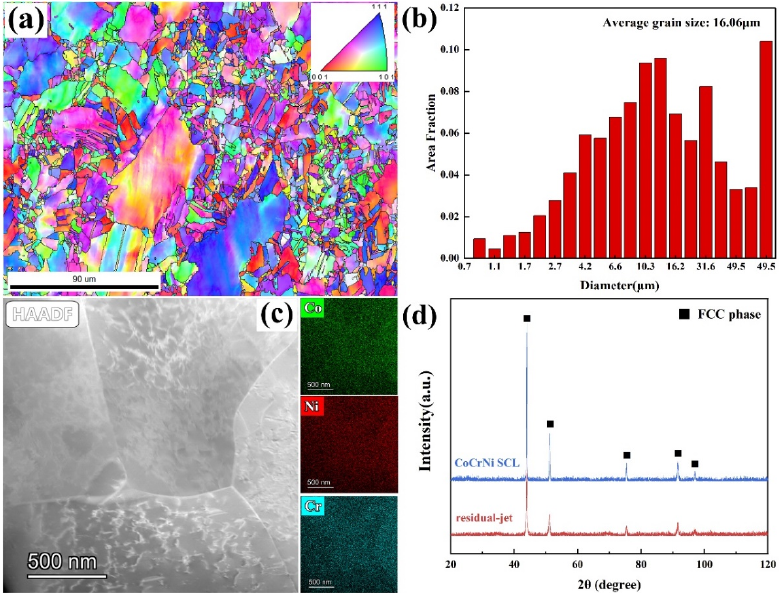
Figure 2. Microstructures and phase compositions of the initial CoCrNi liner. ( a ) EBSD image of the initial CoCrNi liner, indicating an average grain size of 16 µ m. ( b ) Histogram of statistical grain size. ( c ) HAADF image and element distributions of Co, Cr and Ni. ( d ) XRD results of CoCrNi liners before and after